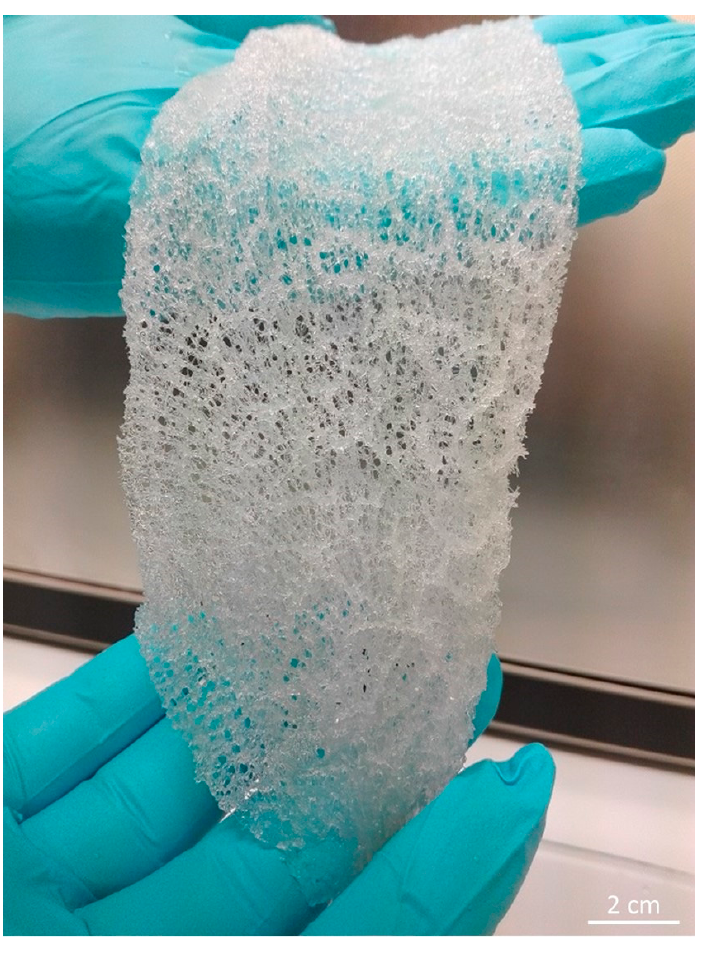
Figure 4. Translucent and mechanically flexible (see also Figure 5) chitinous skeleton of I. labyrinthus isolated after alternating use of acid and alkali treatments for 72 h at 37 °C.